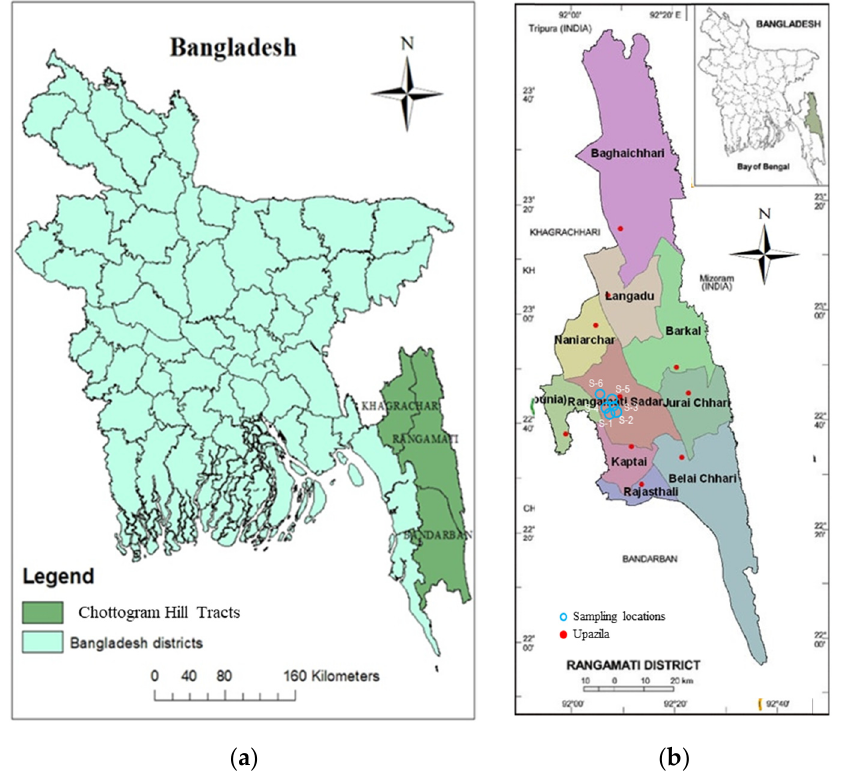
Figure 3. ( a ) Map of Bangladesh showing CHT and Rangamati; ( b ) locations of collected soil samples in